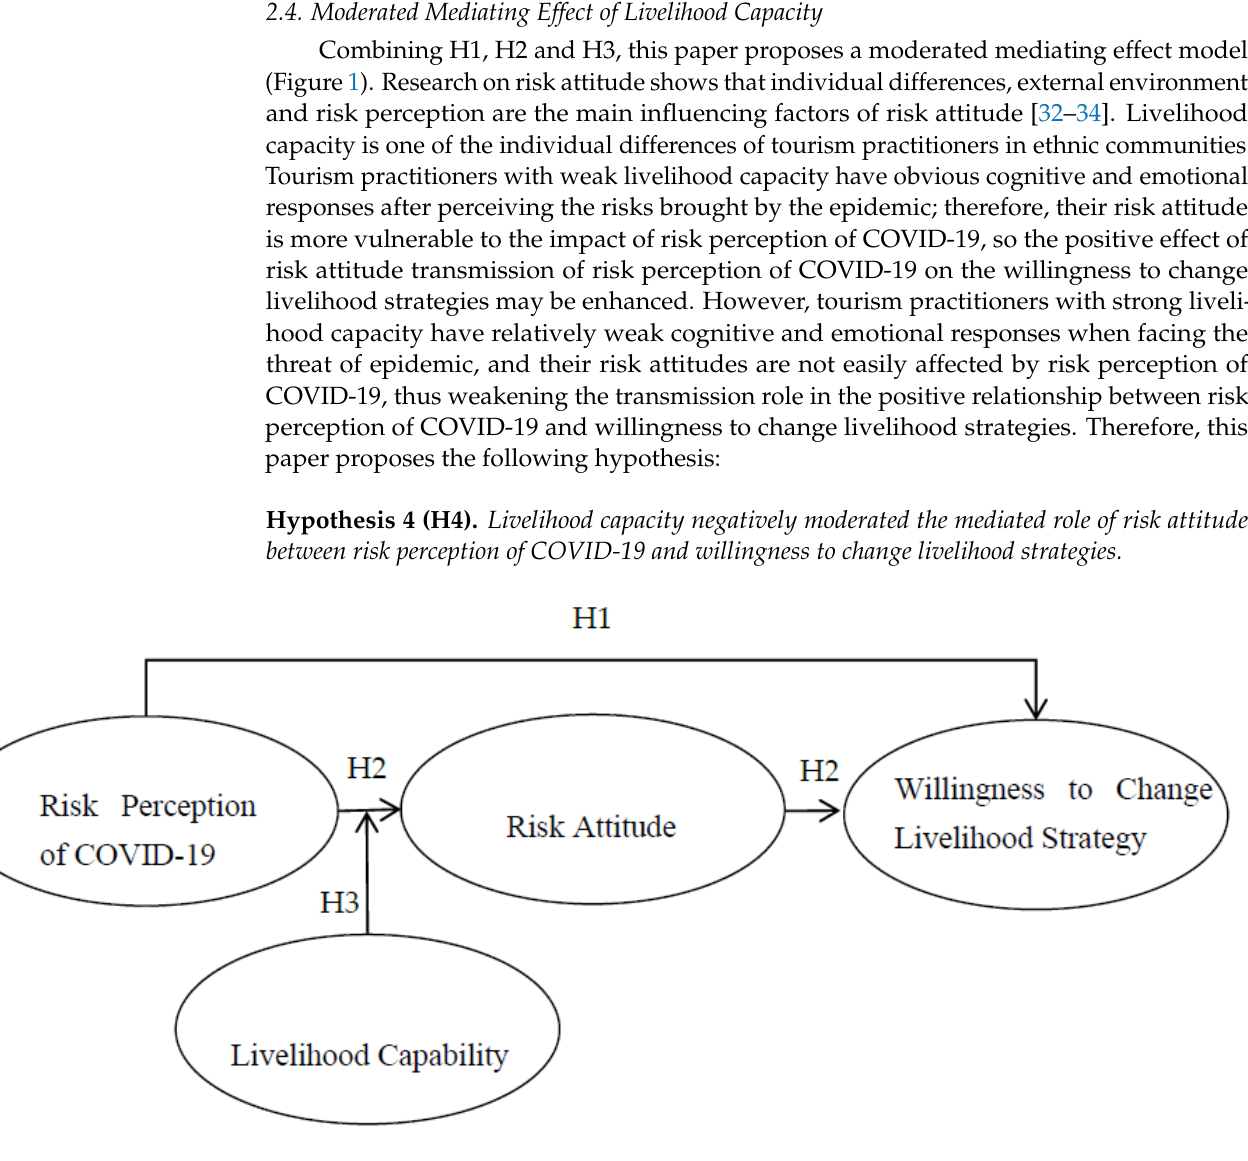
Figure 1. Conceptual